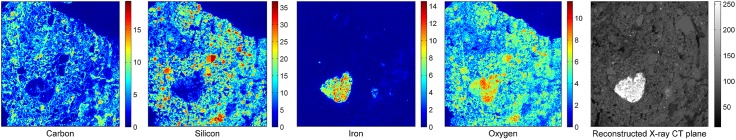
Illustration of SEM-EDX chemical mapping and the corresponding layer within the 3D X-ray CT data.The intensity of the colour indicates the concentration of the elements, whereas the grayscale intensity of the X-ray CT image reflects the density of the material.